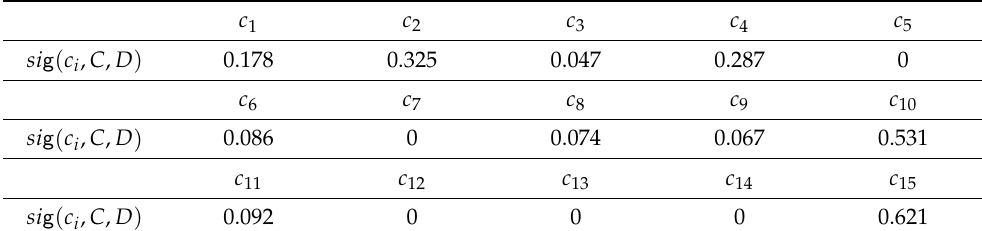
Table 4. The significance of each condition attribute of the right drum.